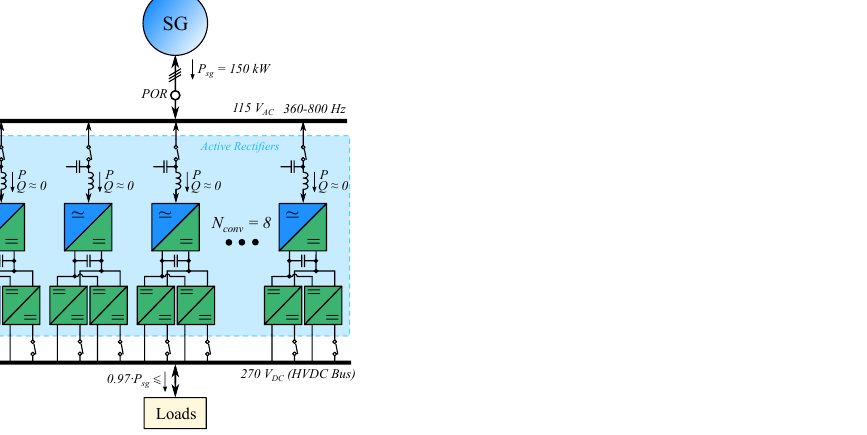
Figure 8. Simplified schema of the proposed active modular 2L 2 architecture